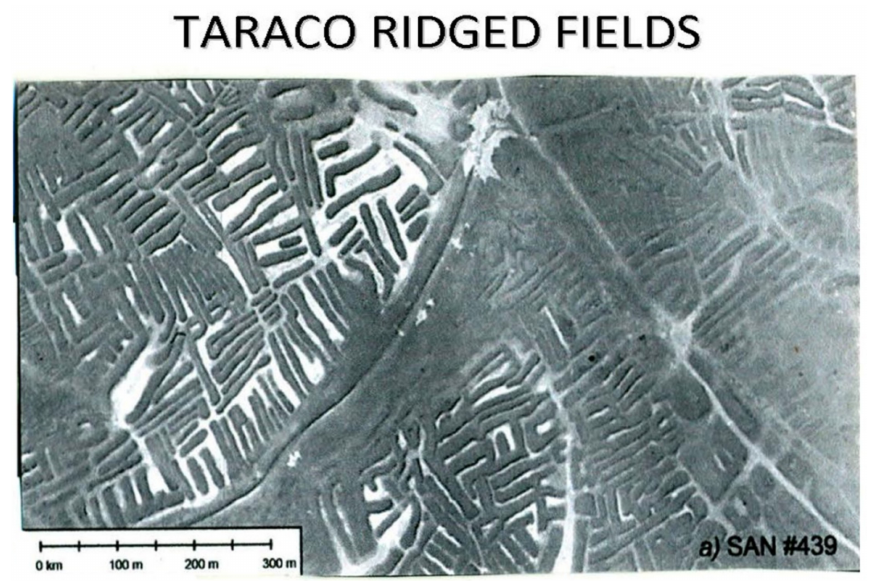
Figure 14. Tarraco raised-field aerial view.